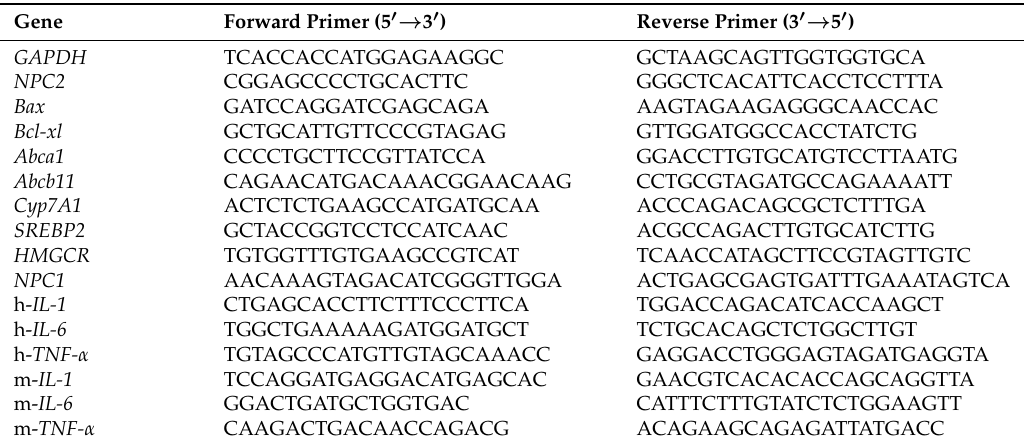
Table 1. Primers used for real-time